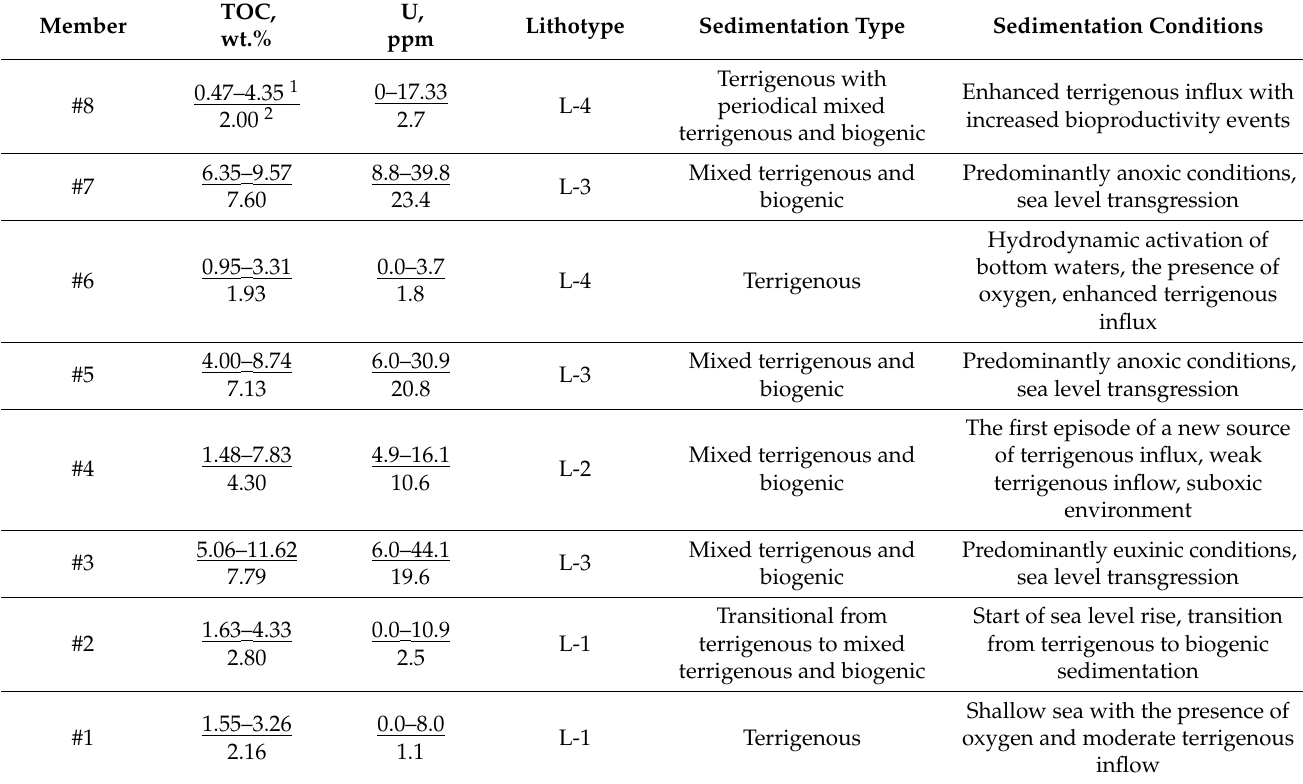
Table 1. Geochemical members and their distinctive characteristics: TOC (pyrolysis) and U content according to gamma-ray spectrometry, genesis